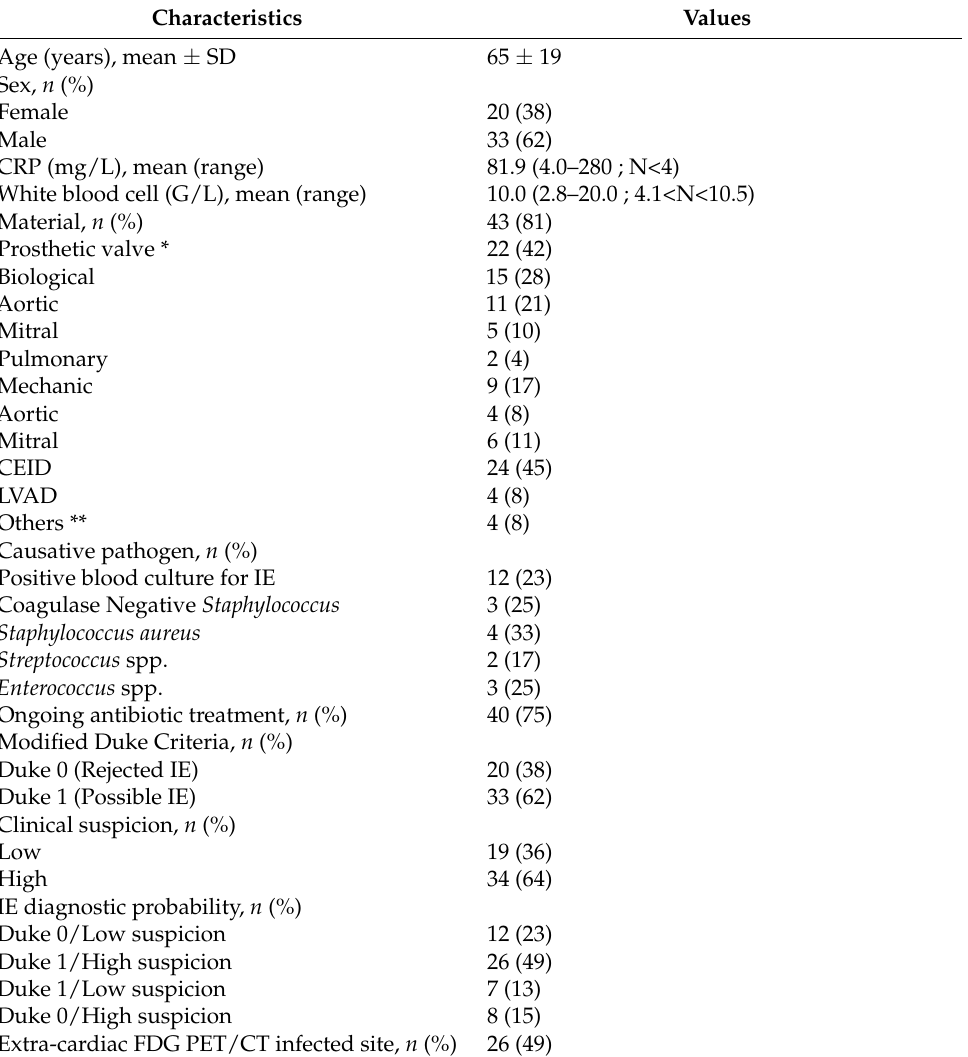
Table 1. Population main characteristics.